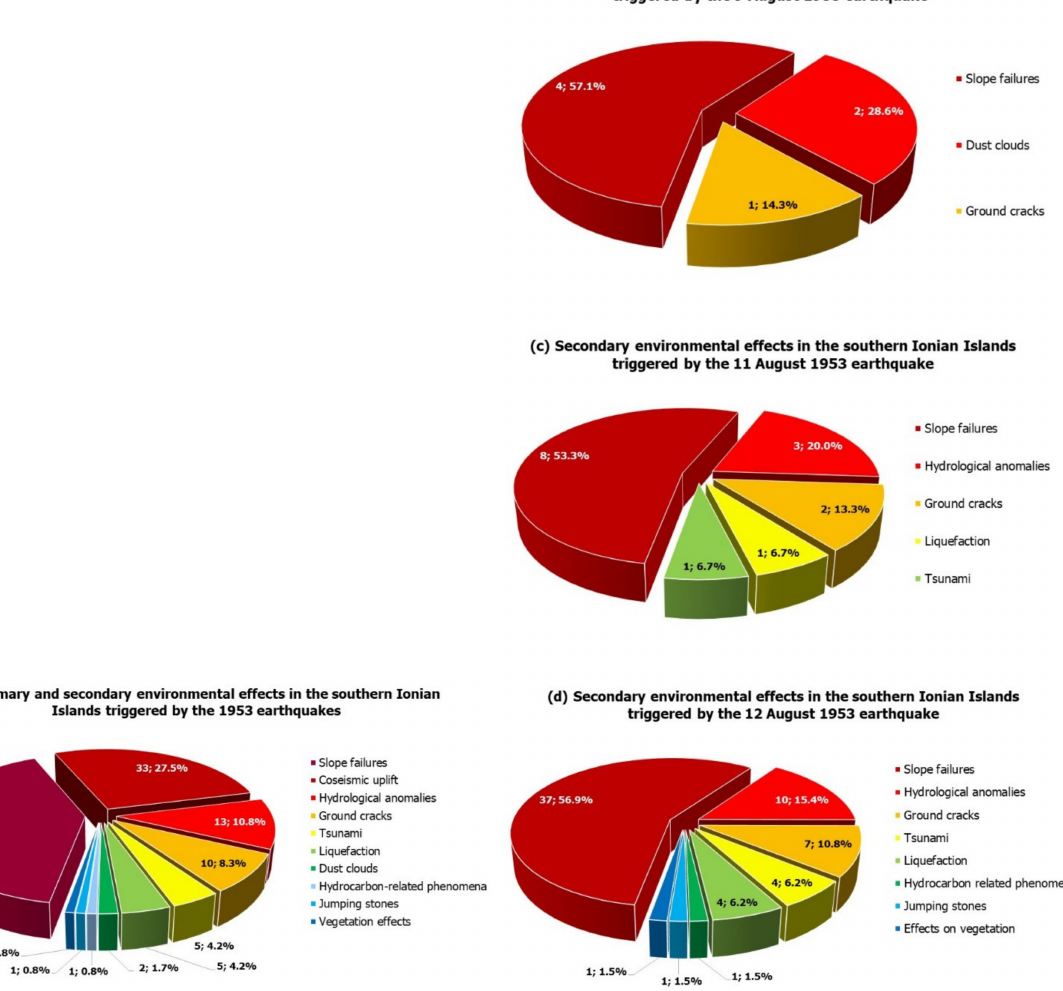
Figure 14. ( a ) Pie chart showing the distribution of all effects triggered by the three studied earthquakes. ( b – d ) Pie charts showing the distribution of the detected primary and secondary effects triggered by the ( a ) 9, ( b ) 11 and ( c ) 12 August 1953 earthquakes on the environment of the southern Ionian Islands and their statistical distribution.